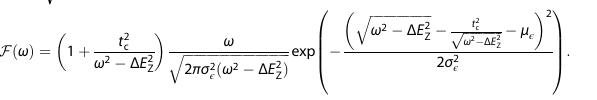
ffiffiffiffiffiffiffiffiffiffiffiffiffiffiffiffiffiffiffi q ω 2 (cid:2) Δ E 2